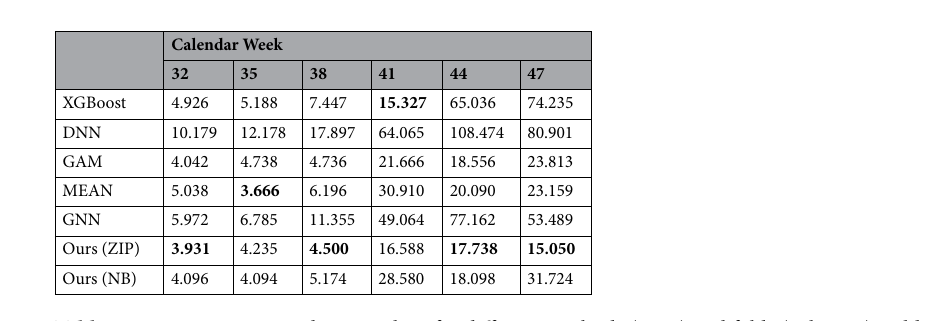
Table 2. Root mean squared error values for different methods (rows) and folds (columns) Bold numbers denote the best result in each fold across all